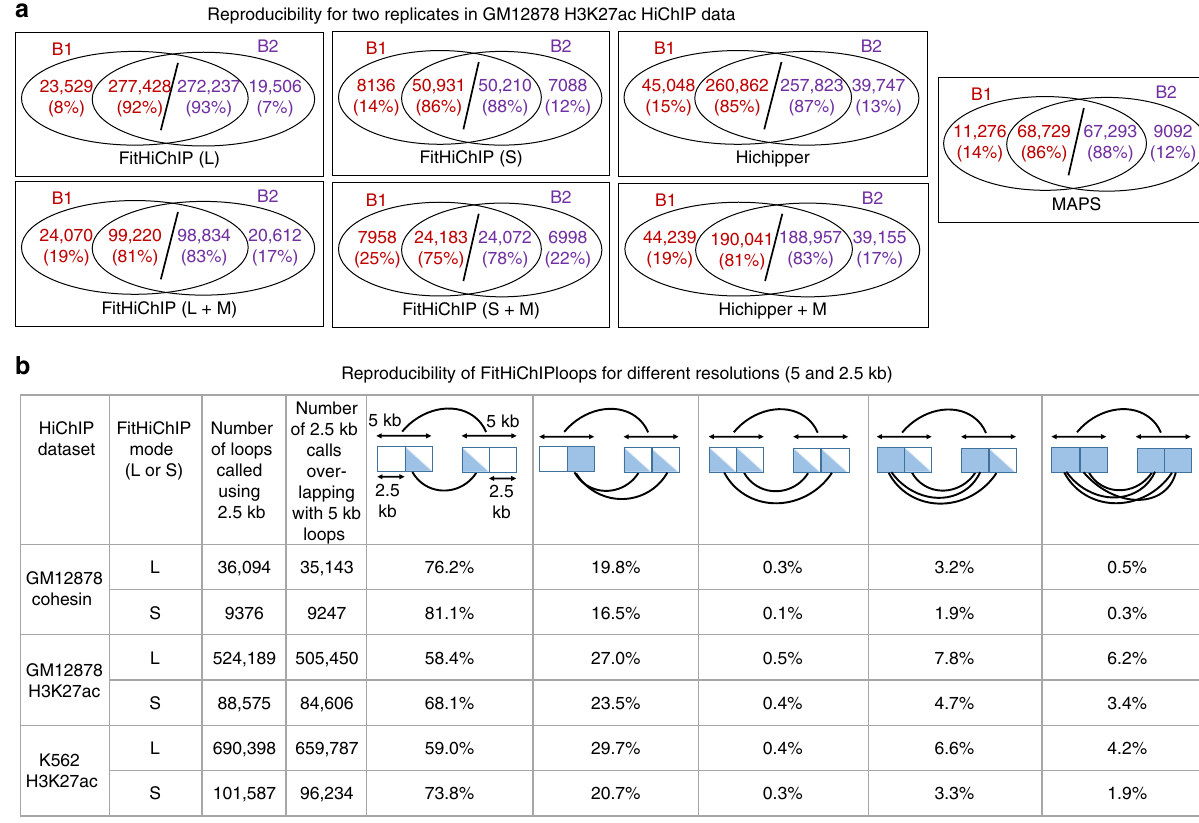
Fig. 5 FitHiChIP calls are reproducible among replicates and across different resolutions. a Overlap between loop calls of different methods for the two biological replicates of GM12878 H3K27ac HiChIP data 19 . Overlapping loops are determined using 5 kb slack (see Methods), and overlap with respect to individual samples are separately shown. b Reproducibility of FitHiChIP results between 5 and 2.5 kb resolution loop calls for different HiChIP datasets. The number of all 2.5 kb loops as well as those overlapping with (i.e., contained within) a 5 kb loop call are listed for each dataset. For the 5 kb loops that overlap at least one 2.5 kb loop, the breakdown of fi ve different possible con fi gurations are illustrated with percentages of such cases shown for each dataset. Source data are provided as a Source Data fi